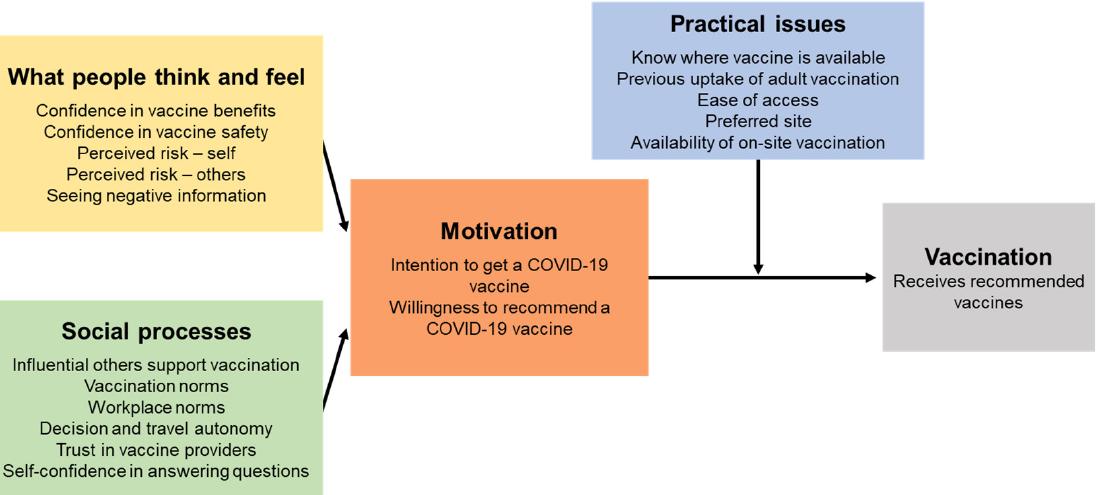
Figure 1. The Behavioural and Social Drivers of COVID-19 vaccination framework [25]. CC BY-NC- SA 3.0 IGO, https://www.who.int/publications/i/item/WHO-2019-nCoV-vaccination-demand- planning-2021.1 (accessed on 15 December